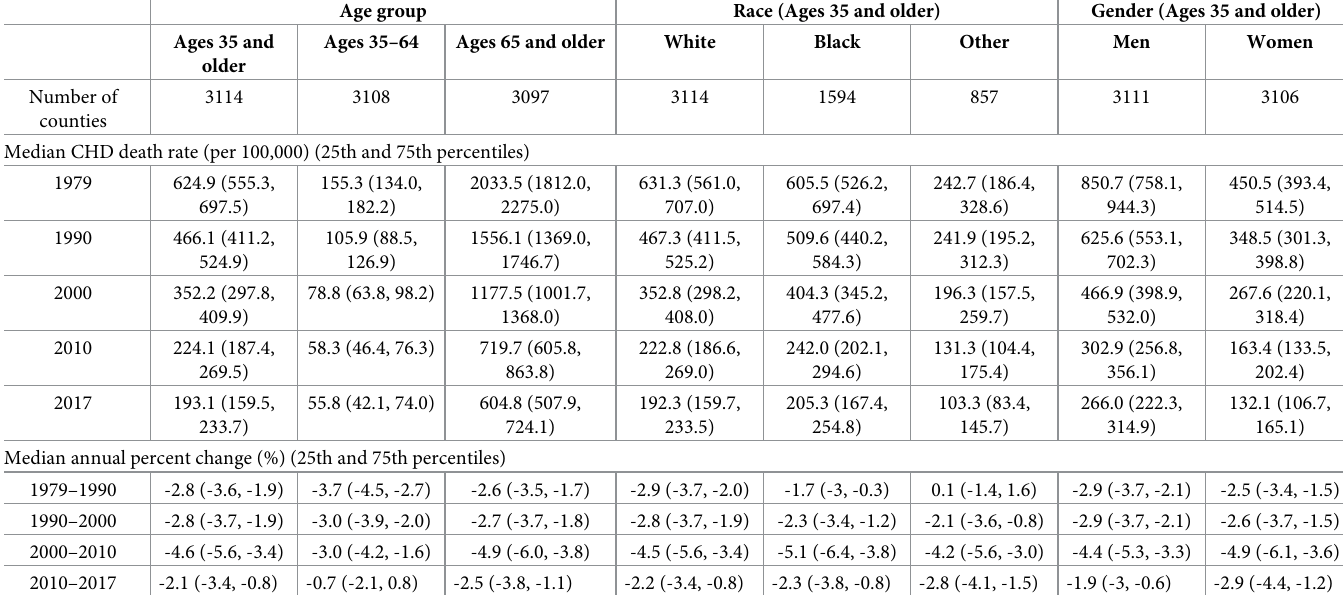
Table 2. County-level distributions of age-standardized CHD death rates and annual percent change in CHD death rates by year, race, gender, and age group, United States,